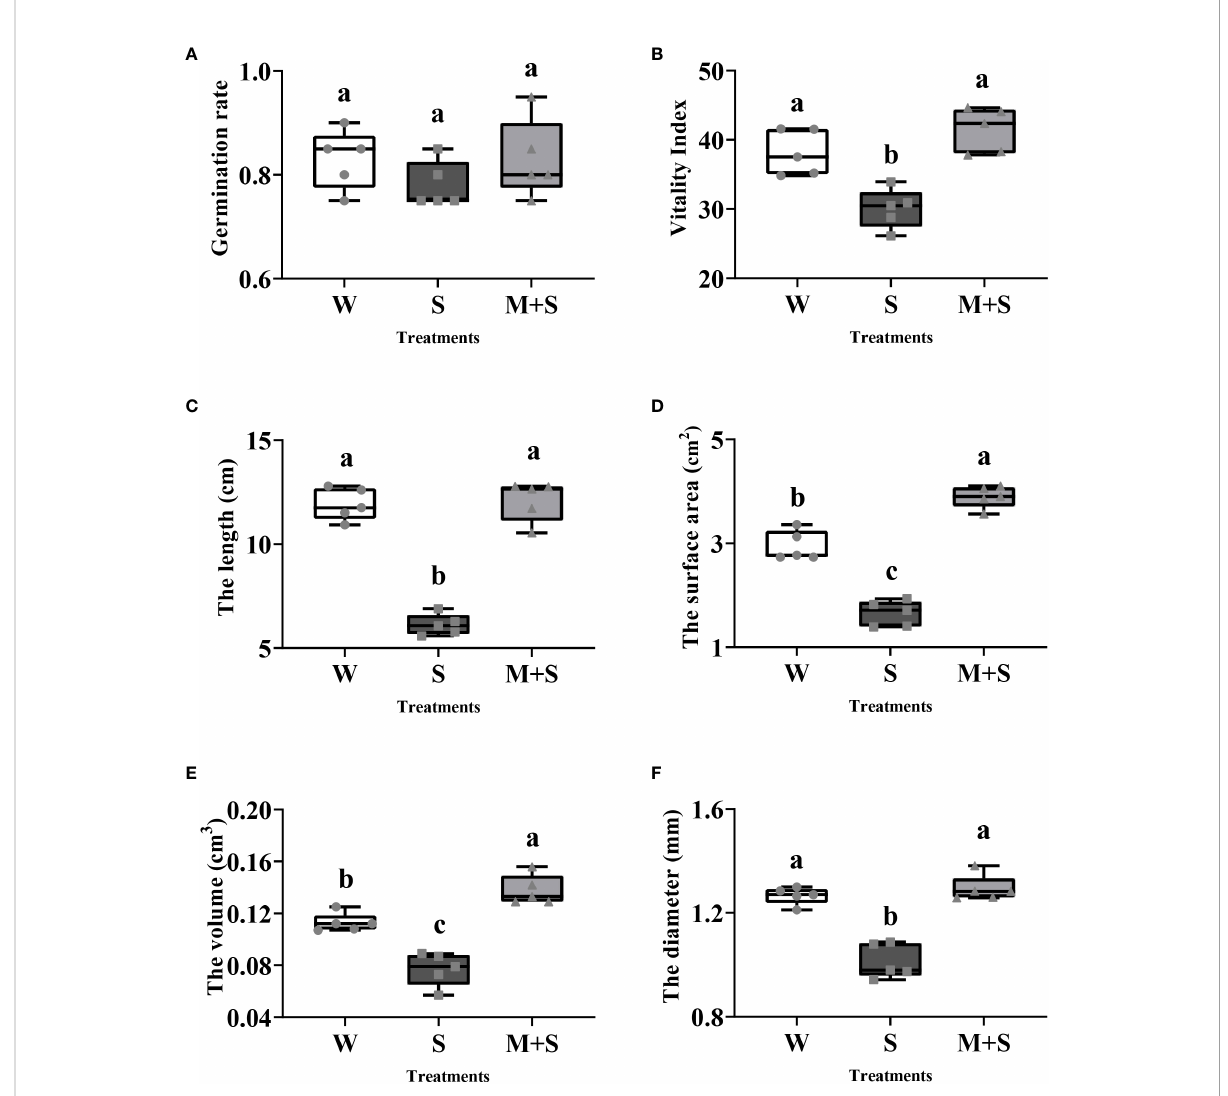
FIGURE 1 Phenotypic analysis of the common bean under W (water), S (salt), and M+S (melatonin with salt) treatments at the sprouting stage. Different lowercase letters in the same column indicate signi fi cant differences between the treatments ( P<0.05 ). Each gray point represents the mean value of the technical replicates. (A) Germination rate; (B) Vitality index; (C) Length; (D) Surface area; (E) Volume; (F)